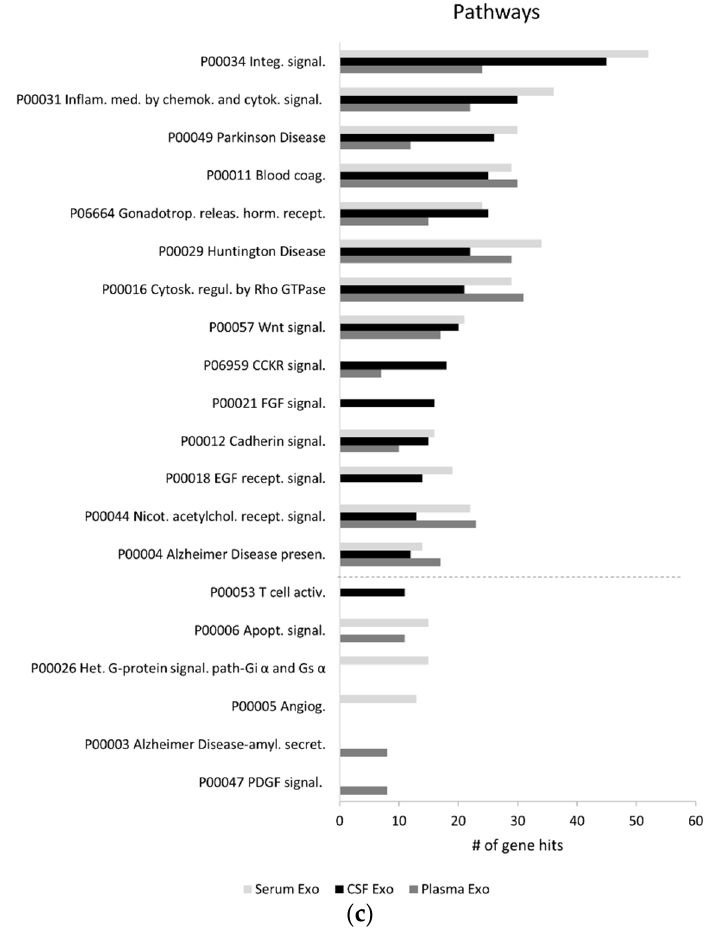
Figure 2. Characterization of the exosomal proteome from distinct biofluids. Exosomal proteomes associated molecular functions ( a ), biological processes ( b ) and pathways ( c ) analysis. Gene ontology (GO) analysis was performed for gene lists corresponding to the exosomal proteomes from serum, plasma and CSF, through the Panther classification system. Exclusive GO terms for exosomes isolated from only one biofluid or shared only by exosomes from two biofluids were represented below the dashed lines. Abbreviations of molecular function GOs terms: GO:0005488 binding;